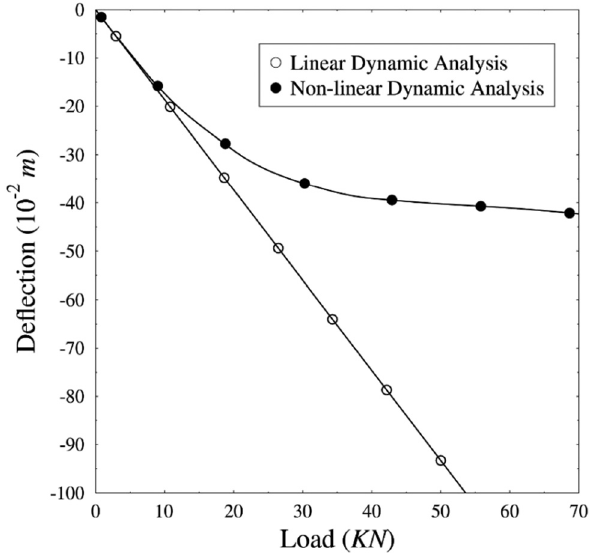
Figure 14: Load – de fl ection curves of CNTFPC fl at panels using linear and nonlinear dynamic analyses.